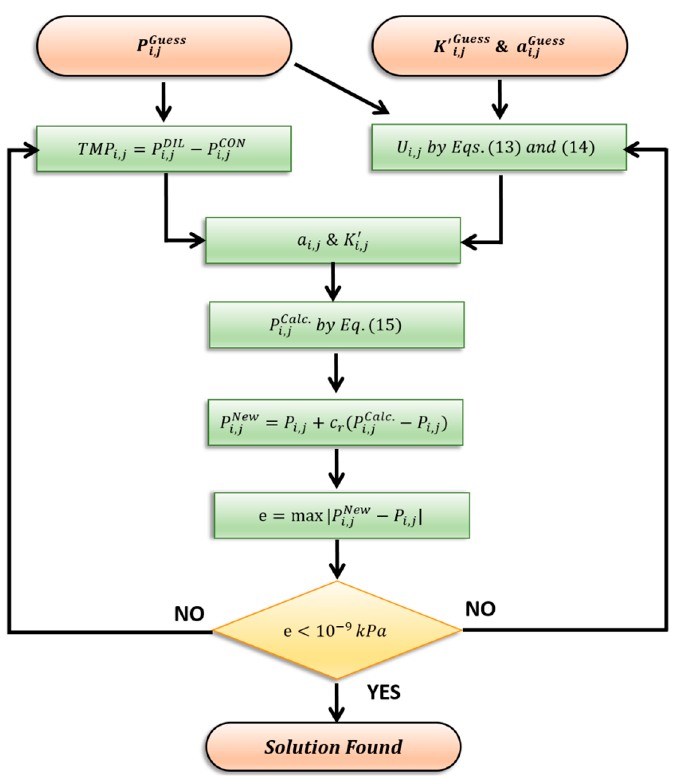
Figure 7. Algorithm flowchart in the case of non-Darcyan flow regime.